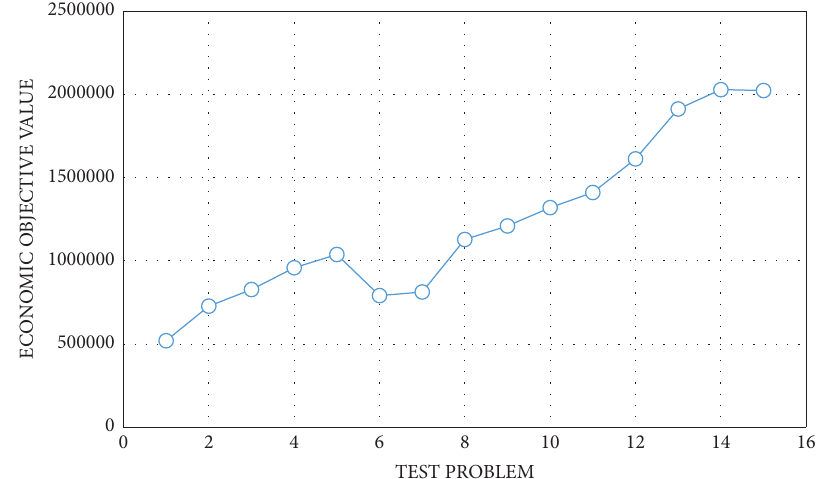
Figure 14: The value of the environmental OF with different scenarios.